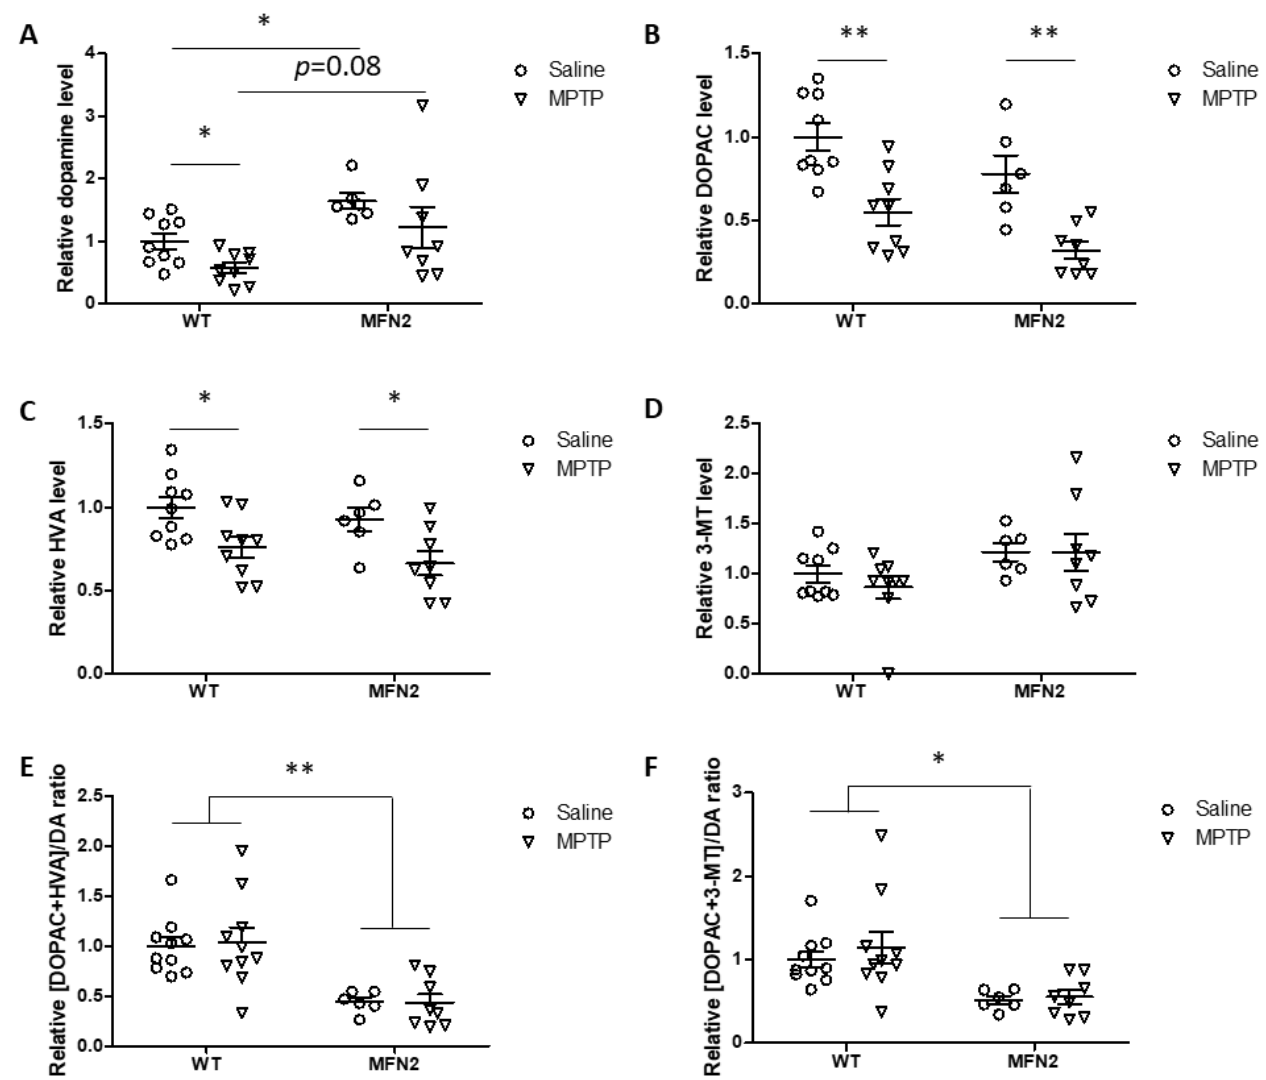
Figure 6. Mfn2 overexpression rescued MPTP-induced striatal dopamine loss. Total dopamine ( A ), DOPAC ( B ), HVA ( C ), and 3-MT ( D ) in striatal tissues from MPTP-treated mice measured by HPLC. Dopamine turnover was calculated as [DOPAC+HVA]/DA ( E ) and [DOPAC+3-MT]/DA ( F ). All the data are shown as relative values. The average levels in the saline-treated WT group were normalized to 1 ( n = 6–10; * p < 0.05 and ** p < 0.01 compared to the control) .